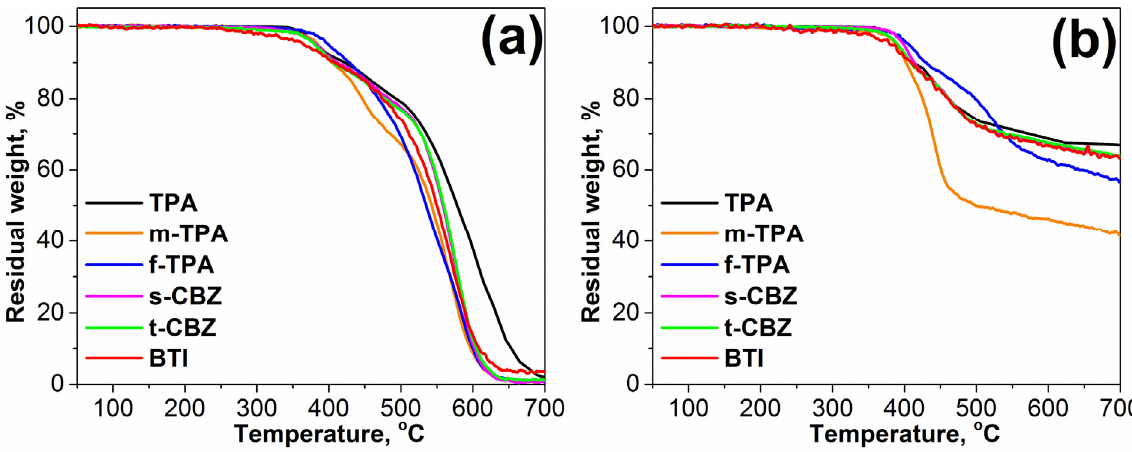
Figure 3. TGA curves of TPA , m-TPA , f-TPA , s-CBZ , t-CBZ and BTI in air ( a ) and under inert atmosphere ( b ). Table 1. Solubility, thermal data and phase behavior of oligomers.